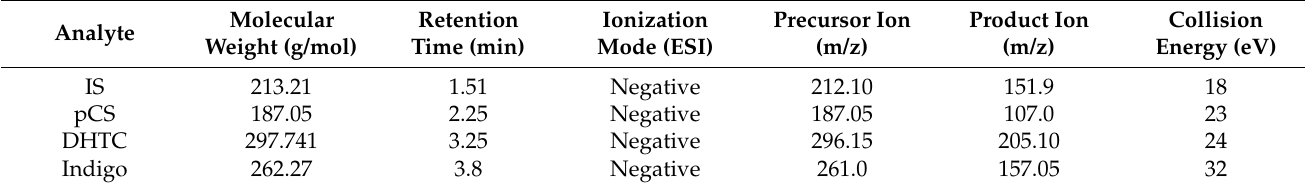
Table 1. Liquid chromatography–tandem mass spectrometry